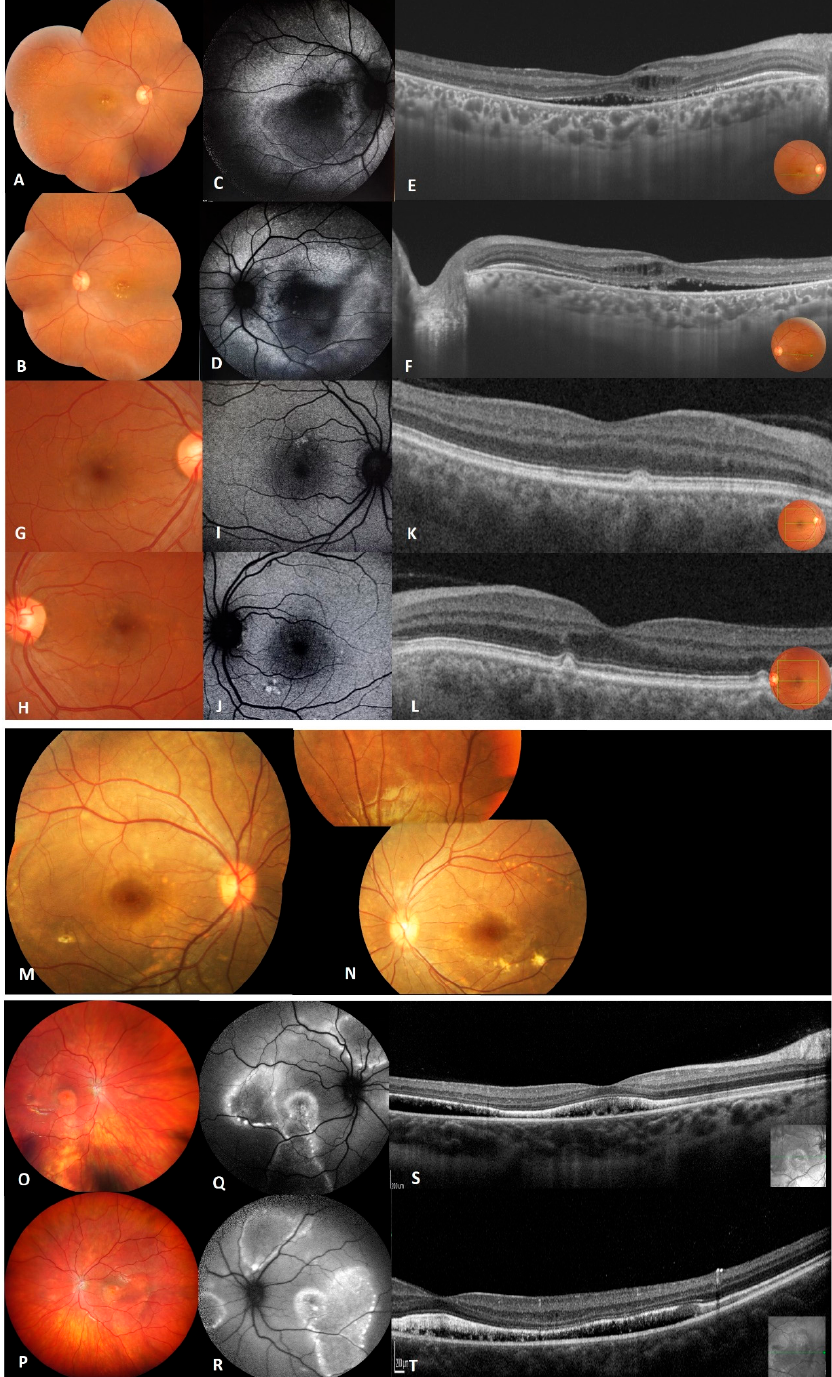
Figure 2. Clinical and imaging features of patients from family A ( A – L ), family B ( M , N ) and family C ( O – T ). ( A , B ) Fundus photographs of right and left eye of proband (II.1) of family A showing